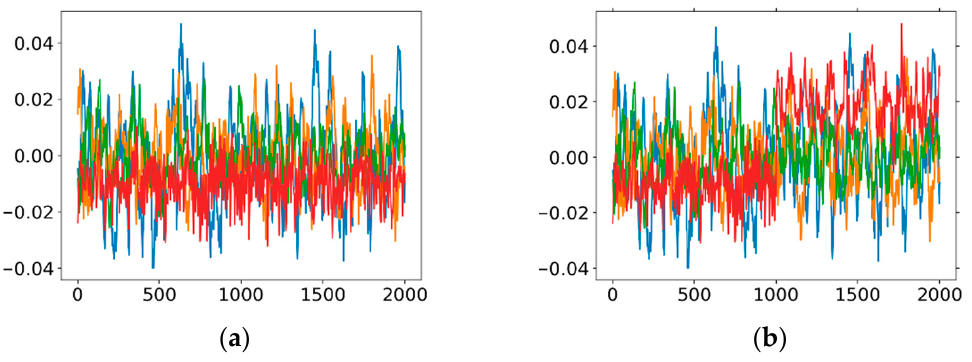
Figure 9. Fault detection results: ( a ) training data set and ( b ) testing data.